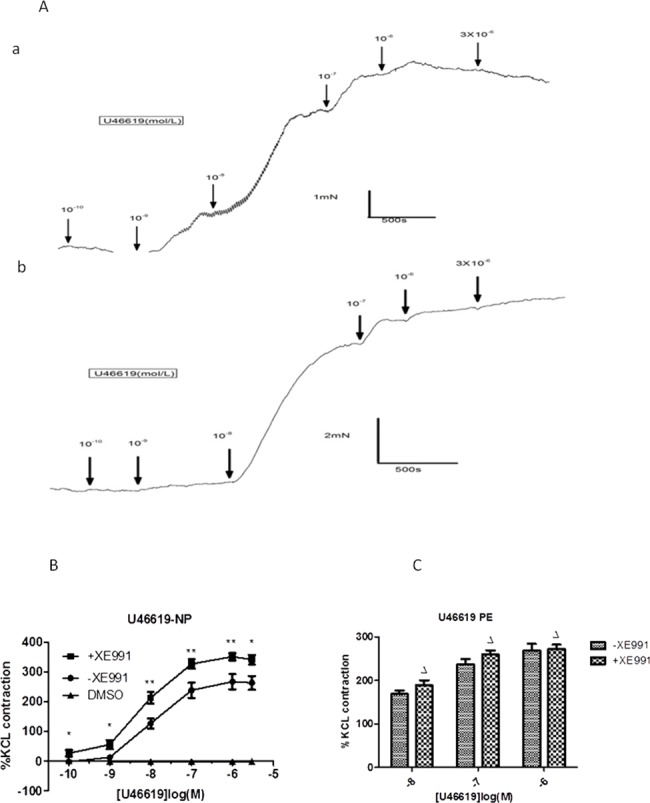
Contraction effects of U46619 in the presence and absence of XE991 (10−5 M/L).(A)The representative tracings of changes in tension of the chorionic plate arterial ring from normotensive women in response to the cumulative addition of U46619 (thromboxane receptor agonist) from 10-10mol/L to 3X10-6mol/L. The panel a shows the response to U46619 without incubation of XE991(10−5 M/L) The panel b shows the response to U46619 in the presence of XE991(10−5 M/L) (B) Concentration response curves(mean±SD; n = 10 vessels, N = 10 placentas) for U46619(10−10-3X10-6 mol/L) in the presence and absence of XE991(10−5 M/L) on the chorionic plate arteries from normotensive women.(*P<0.05, **P<0.01, +XE991 vs.–XE991, two-way ANOVA). (C) Comparison of contraction effects of U46619 (10−8–10−6 mol/L) on chorionic plate arteries from preeclampsia women in the presence and absence of XE991 (10−5 M/L). (ΔP>0.05, +XE991 vs.–XE991, two-way ANOVA).